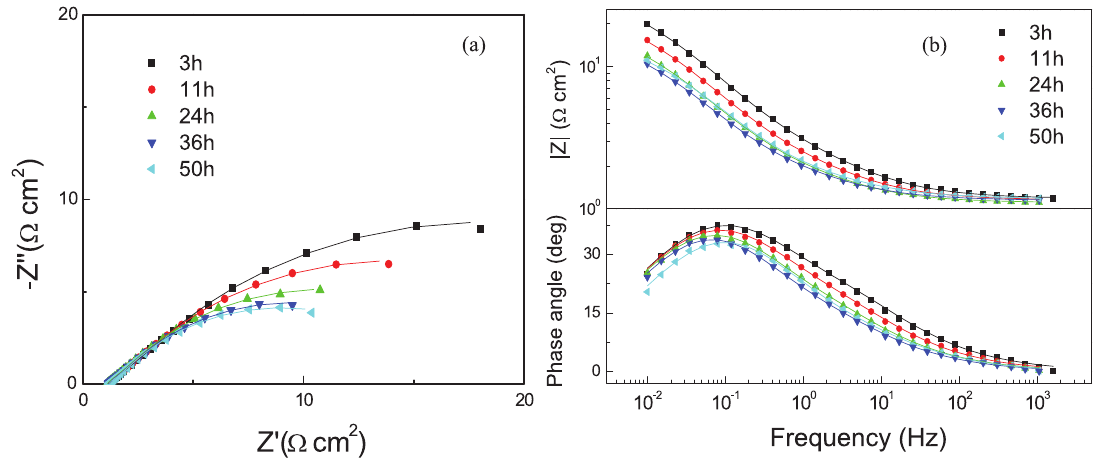
Fig. 3: Nyquist (a) and Bode (b) diagrams of pure iron in molten (Li,Na,K)F at 973 K (Symbol: experimental data; Line: fitted